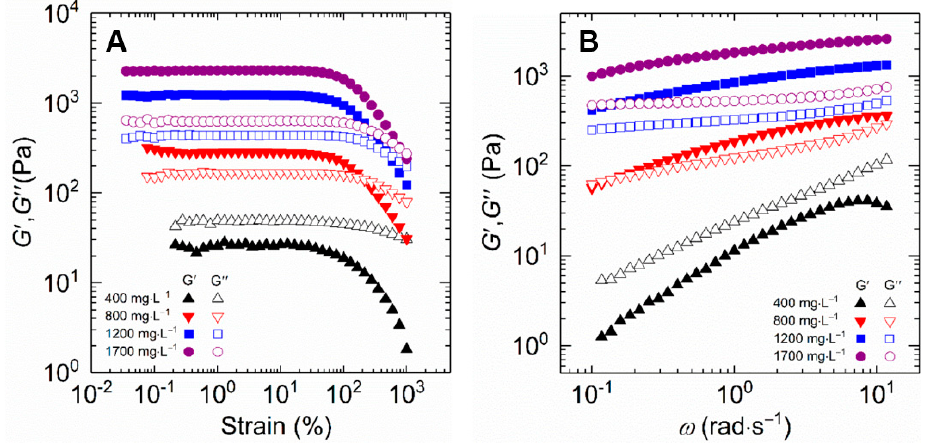
Figure 8. The storage and loss modulus plotted as a function of ( A ) strain and ( B ) frequency for HVFR solution at 30 °C.